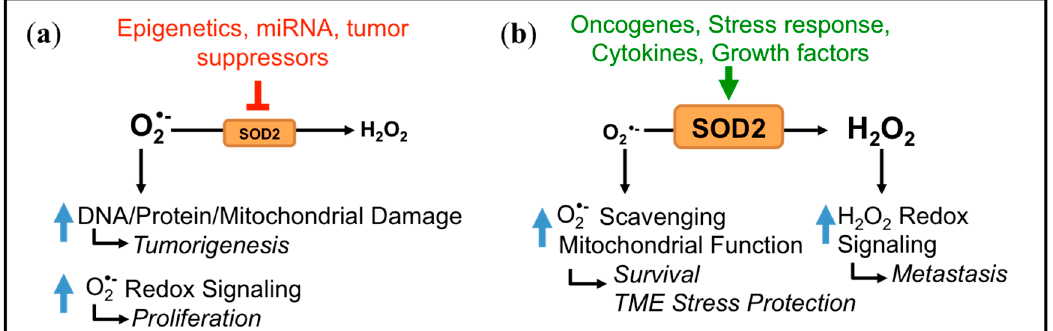
Figure 2. The dichotomous role and regulation of SOD2 in cancer. SOD2 changes the redox status of mitochondria, whereby negative regulation of SOD2 can result in O 2 • − -driven tumorigenesis and proliferation, supporting a tumor-suppressive function for SOD2 ( a ). Conversely, activation